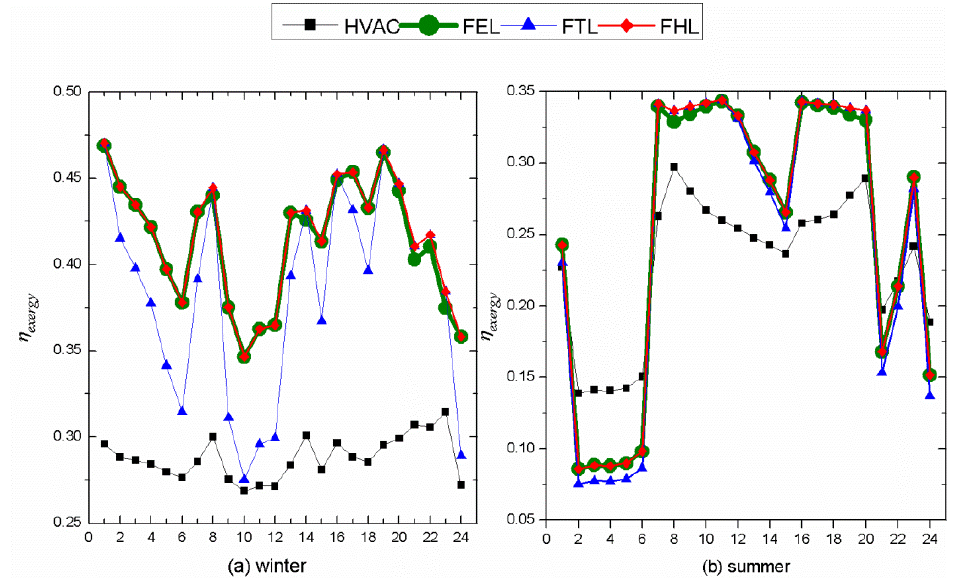
Figure 6. Exergy efficiencies of HVAC system and different operation modes of CCHP system in representative ( a ) winter and ( b ) summer days based on simulated data.